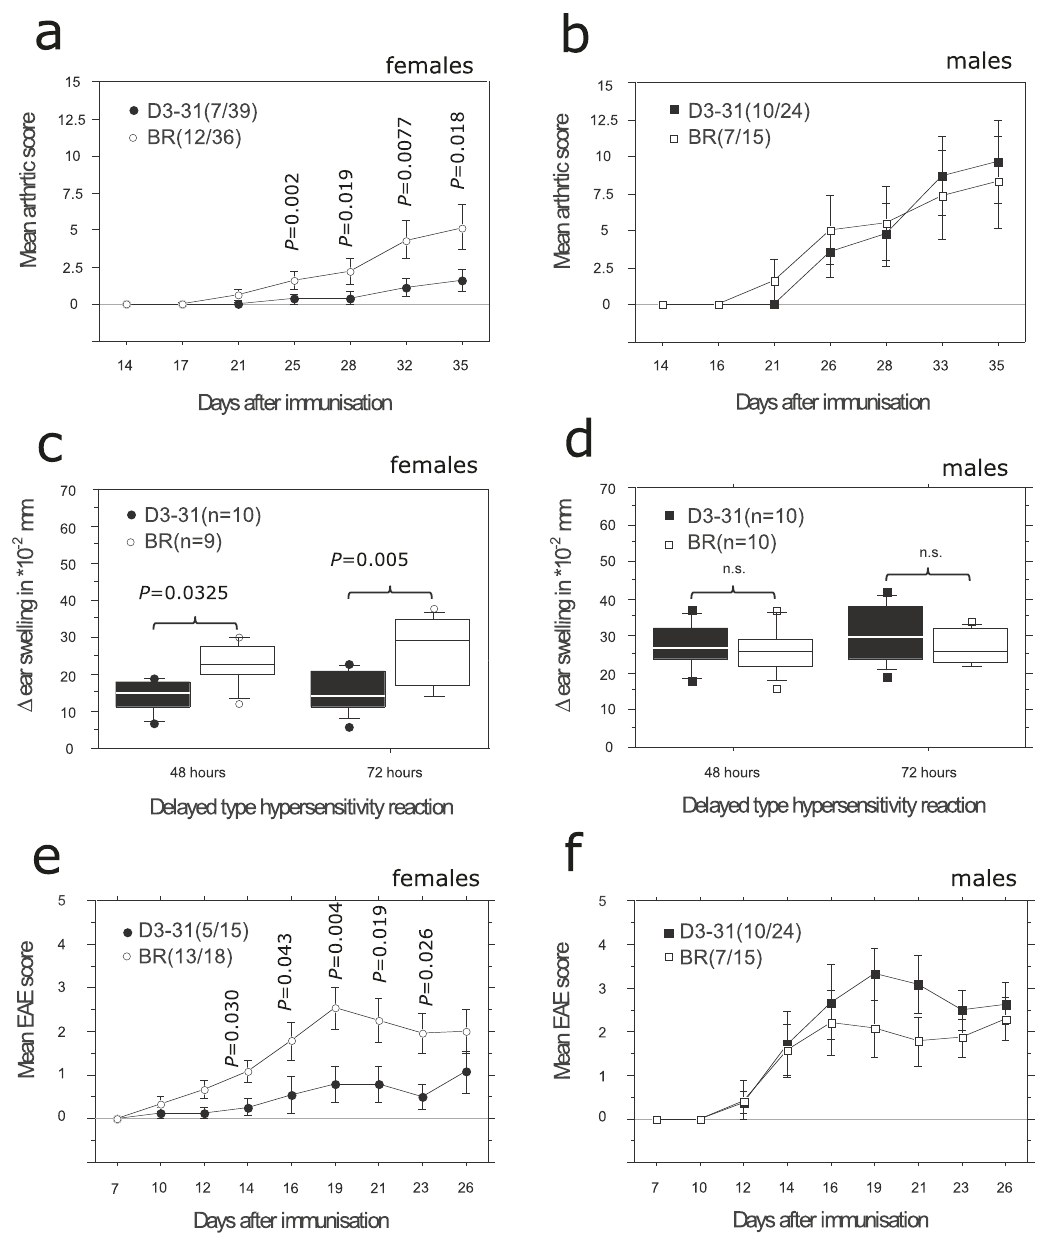
Fig. 2 D3-31 mice are protected from T cell-dependent autoimmunity in a sex-speci fi c manner. Collagen-induced arthritis (CIA) in a female and b male BR and D3-31 mice. Data was pooled from two independent experiments. Delayed-type hypersensitivity (DTH) reaction in c female and d male BR and D3- 31 mice. Box upper and lower limits indicate interquartile range (25th/75th percentiles), the middle line indicates the median. Whiskers indicate 10th and 90th percentiles. Min. and max. values are plotted as individual dots. Data is representative of three independent experiments with similar results. MBP89- 101-induced experimental autoimmune encephalomyelitis (EAE) in e female and f male BR and D3-31 mice. Data was pooled from two independent experiments. For all graphs, incidence and total number of mice used are indicated in parenthesis. Data are summarised as mean (SEM). Statistical signi fi cance was evaluated using a two-tailed non-parametric Mann – Whitney U